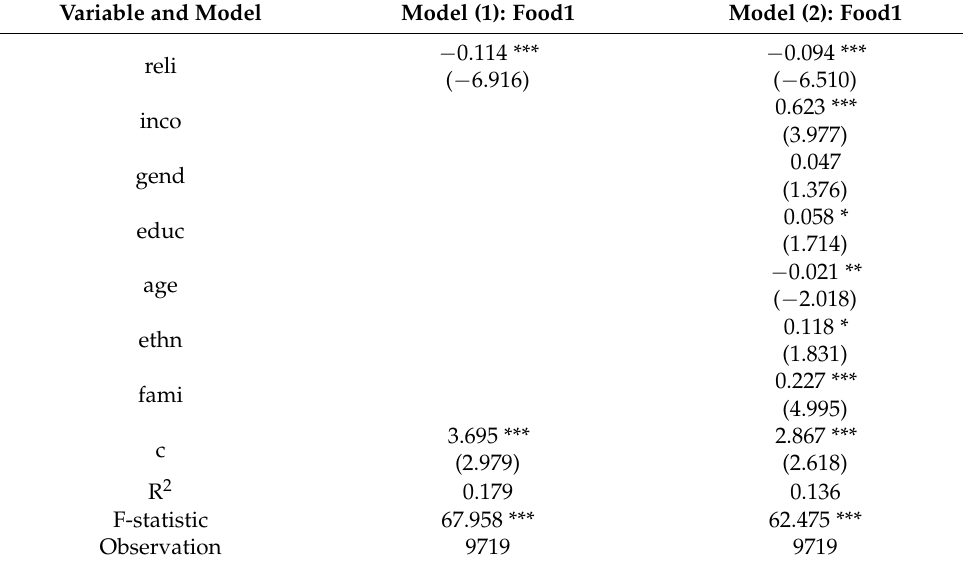
Table 3. Results of the effect of religious participation on food consumption. Variable and